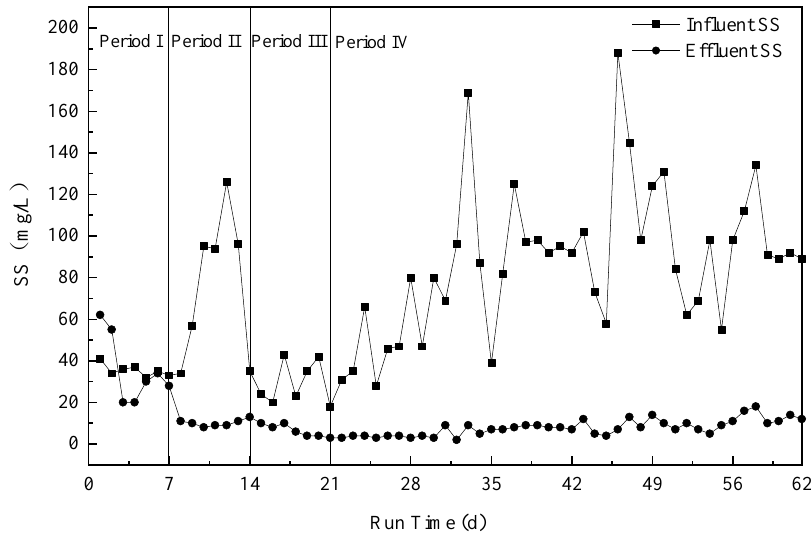
Figure 4. SS change under different run times in the ALBR system.